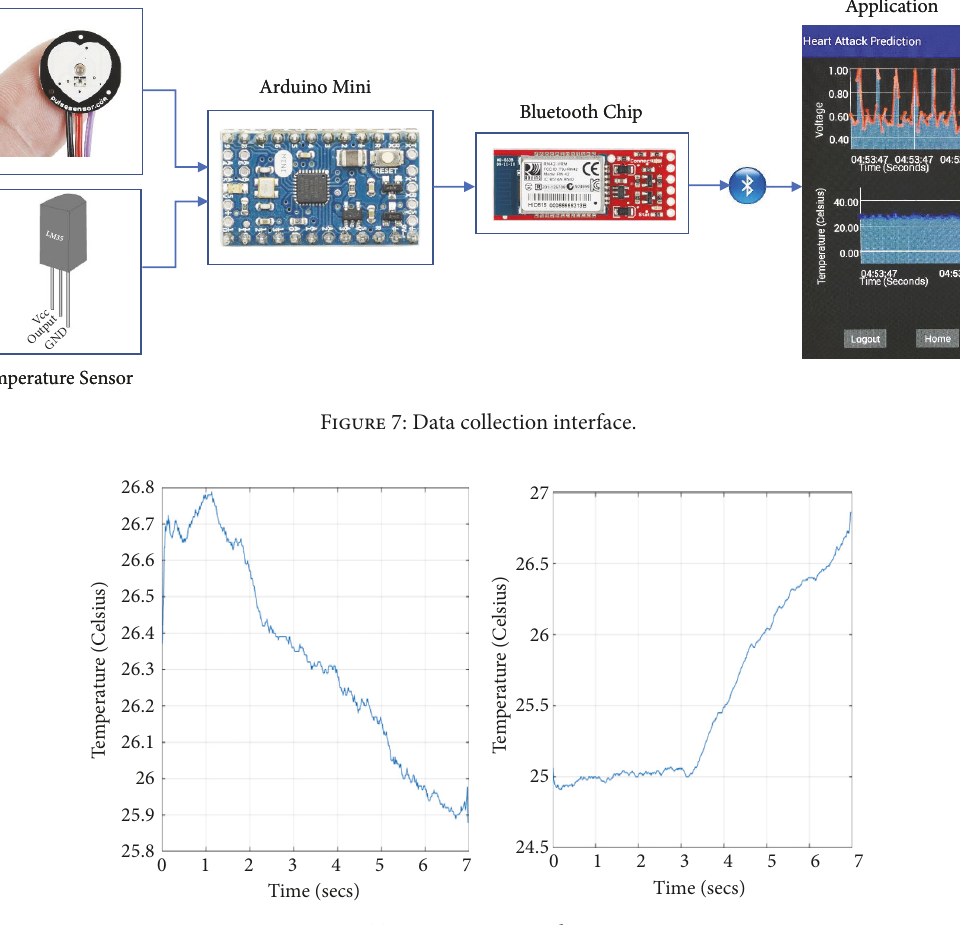
Figure 8: Temperature sensor data